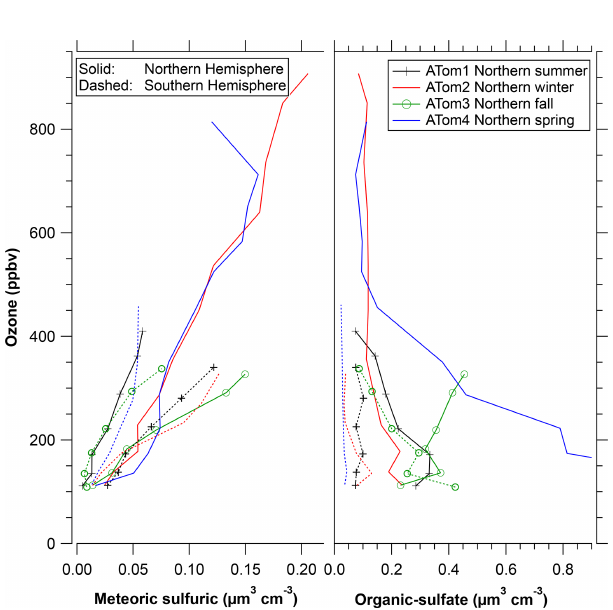
Figure 5. Profiles of the volume concentration of two types of parti- cles in the lower stratosphere, using ozone as a surrogate for a verti- cal coordinate. This does not include particles smaller than 0.1µm. Sulfuric acid particles with meteoric metals have a high-altitude source, whereas organic–sulfate particles, as selected by their mass spectra, originate in the troposphere. The organic–sulfate particles are more abundant in the Northern Hemisphere than they are in the Southern